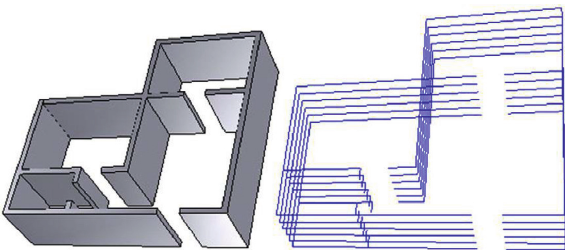
Figure 3: A structure and its CC tool path